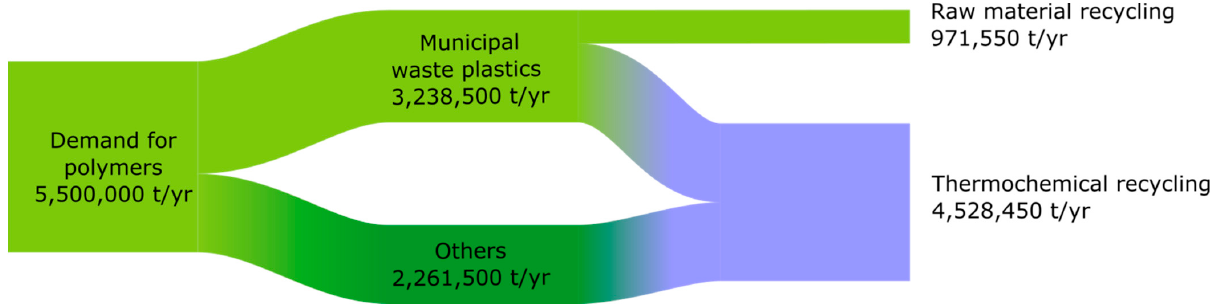
Figure 6. Distribution scheme of plastic waste in Poland, prognosis for 2050 .